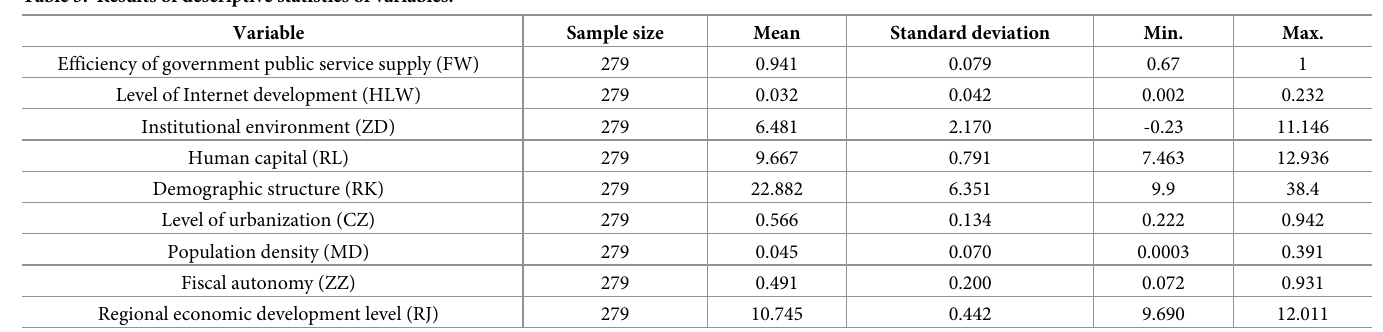
Table 3. Results of descriptive statistics of variables.